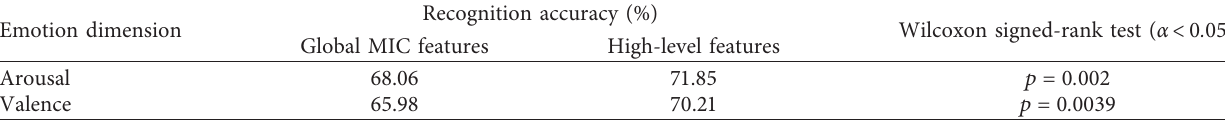
Table 3: Comparison between the global MIC features and high-level